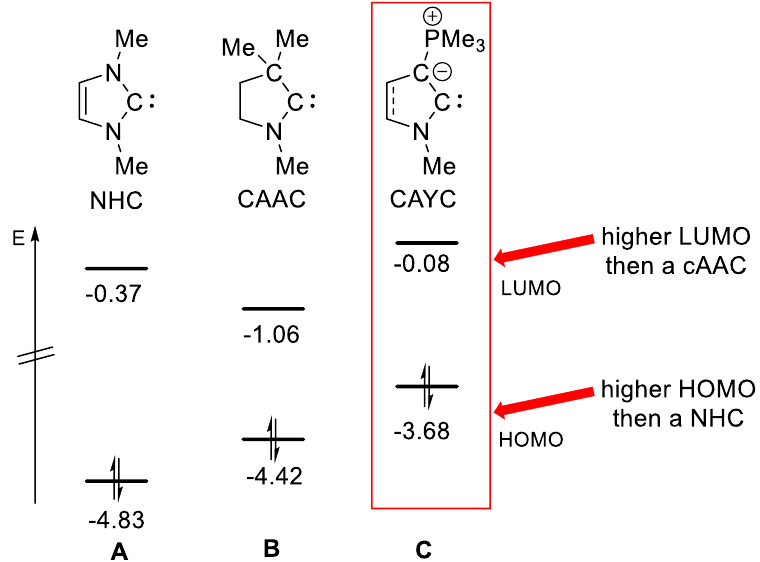
Figure 1. Schematic representation of the HOMO and LUMO properties of different singlet carbenes. Eigenvalues of the frontier orbitals were taken from Reference [21].